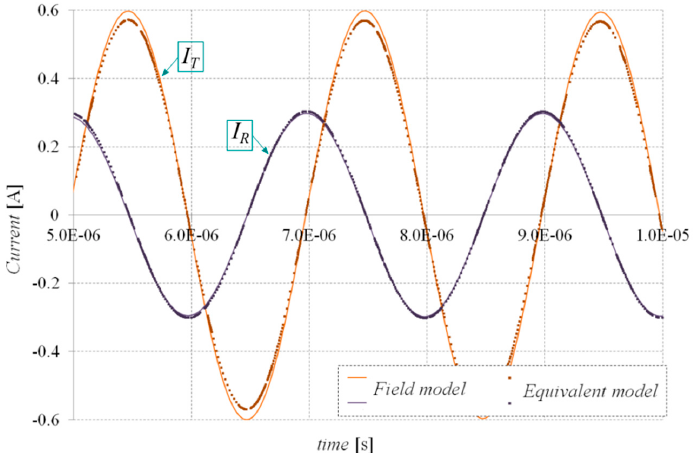
Figure 7. Comparison of receiver and transmitter currents of the WPTS determined by 3D FEA